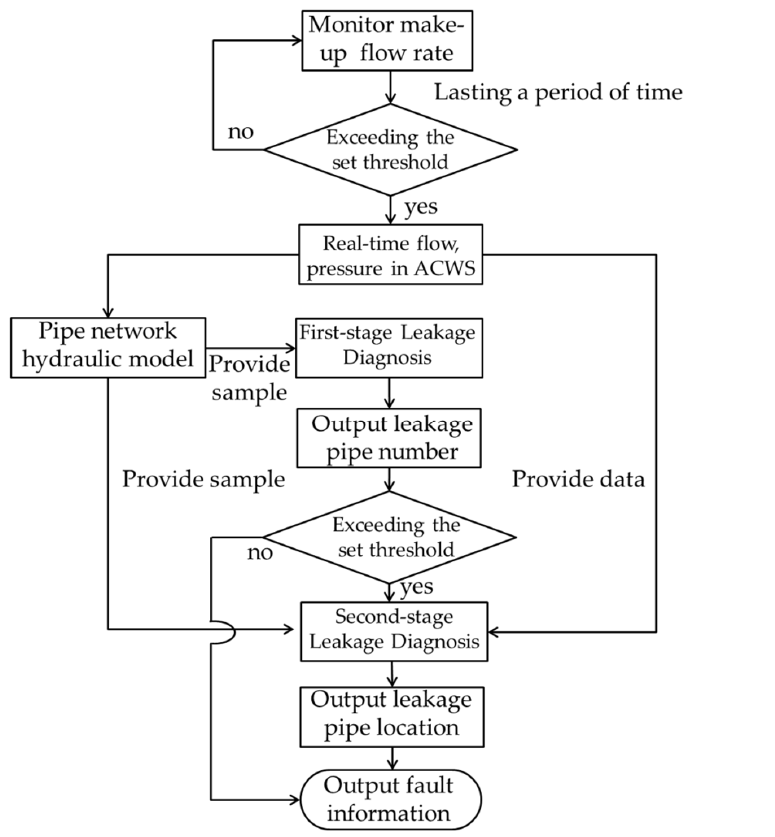
Figure 3. Research diagram of two-stage leakage diagnosis in